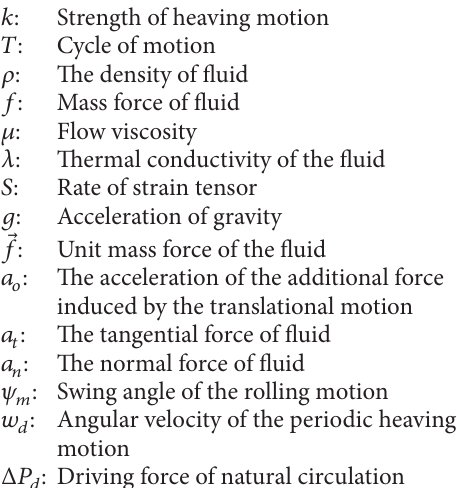
were investigated and mechanism of natural circulation in heaving motion was stated. Results indicated the